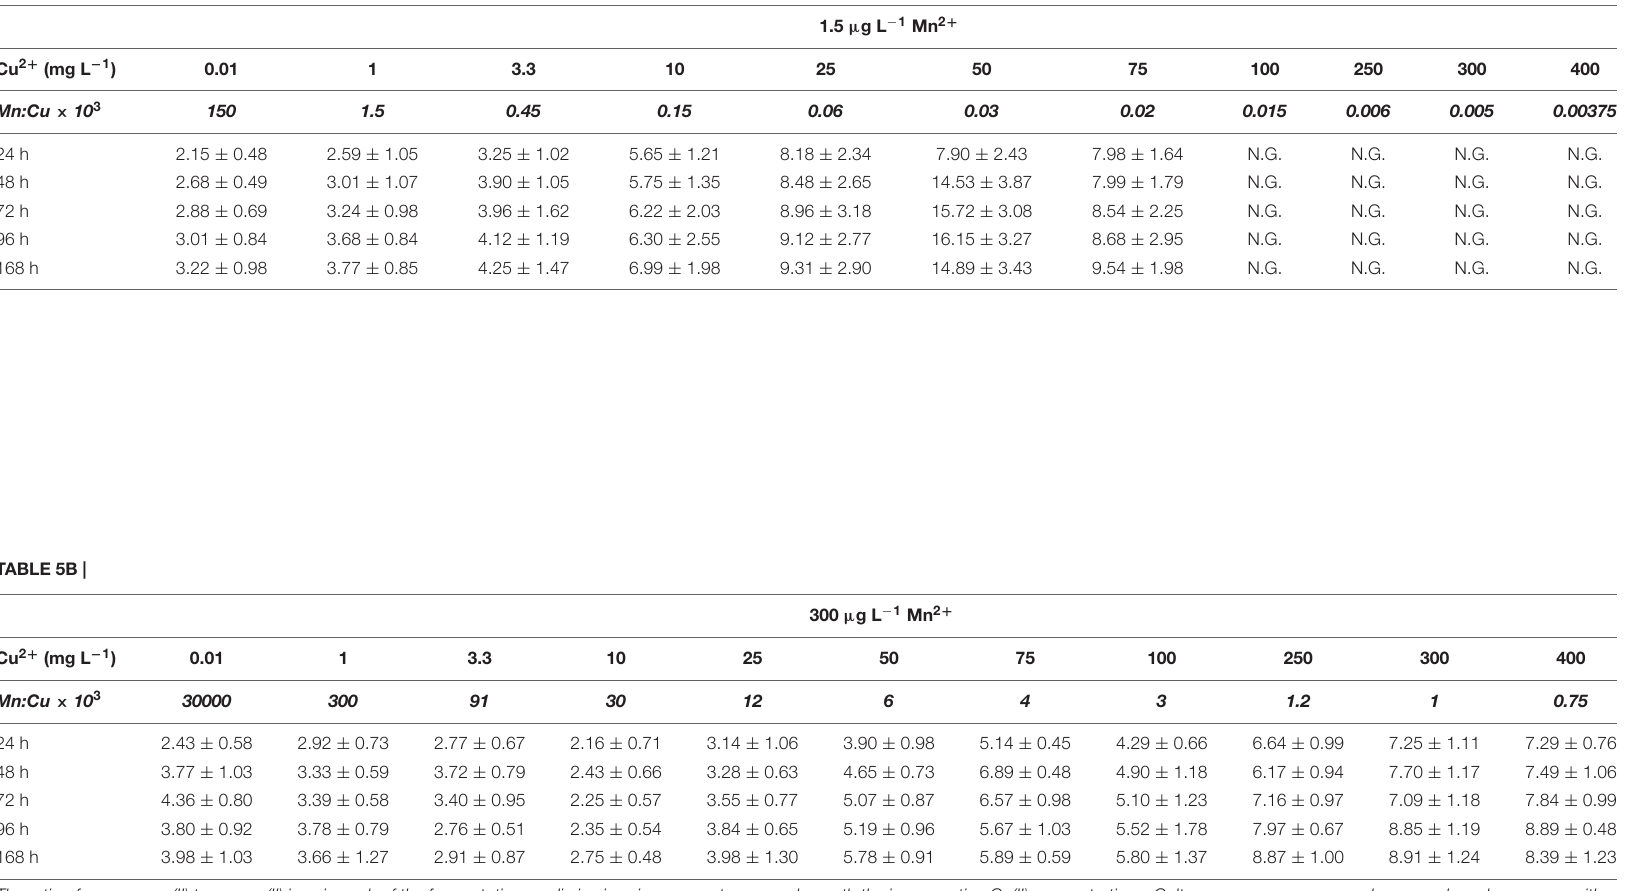
TABLE 5A | Average cell diameter in A. terreus NRRL1960 D -xylose-grown mycelia as a function of the copper(II) ion concentration in the culture broth at Mn(II) limitation and